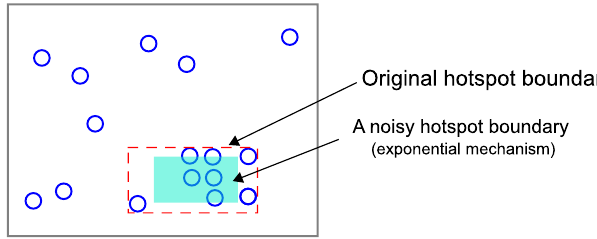
Figure 7. A noisy hotspot boundary of Figure 6d by Algorithm